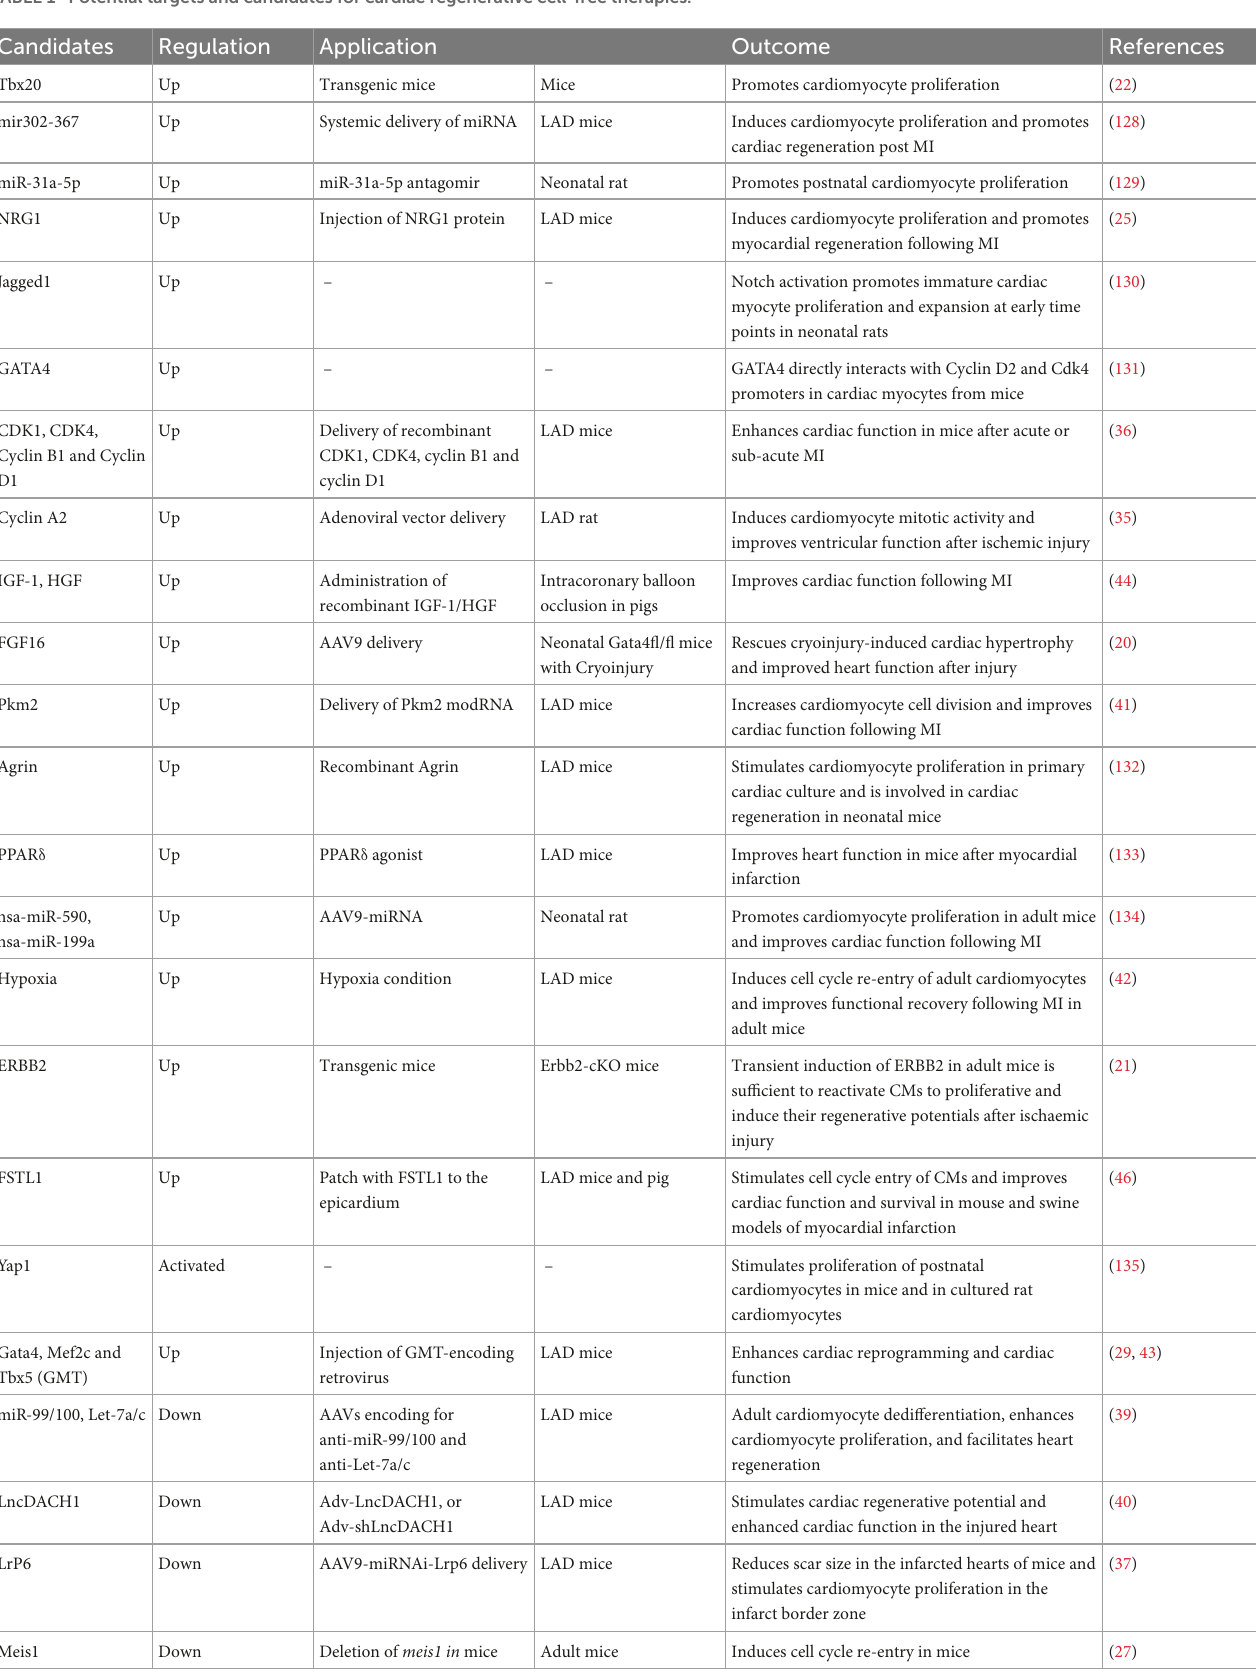
TABLE 1 Potential targets and candidates for cardiac regenerative cell-free